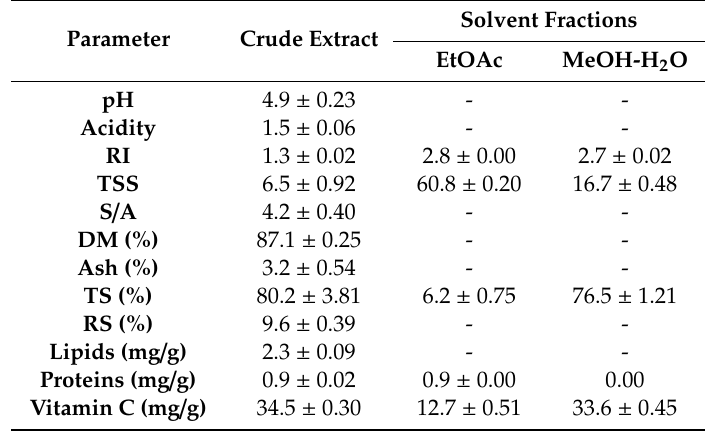
Table 1. Di ff erent physico-chemical parameters of Z. Lotus samples. The results are expressed as mean ± standard